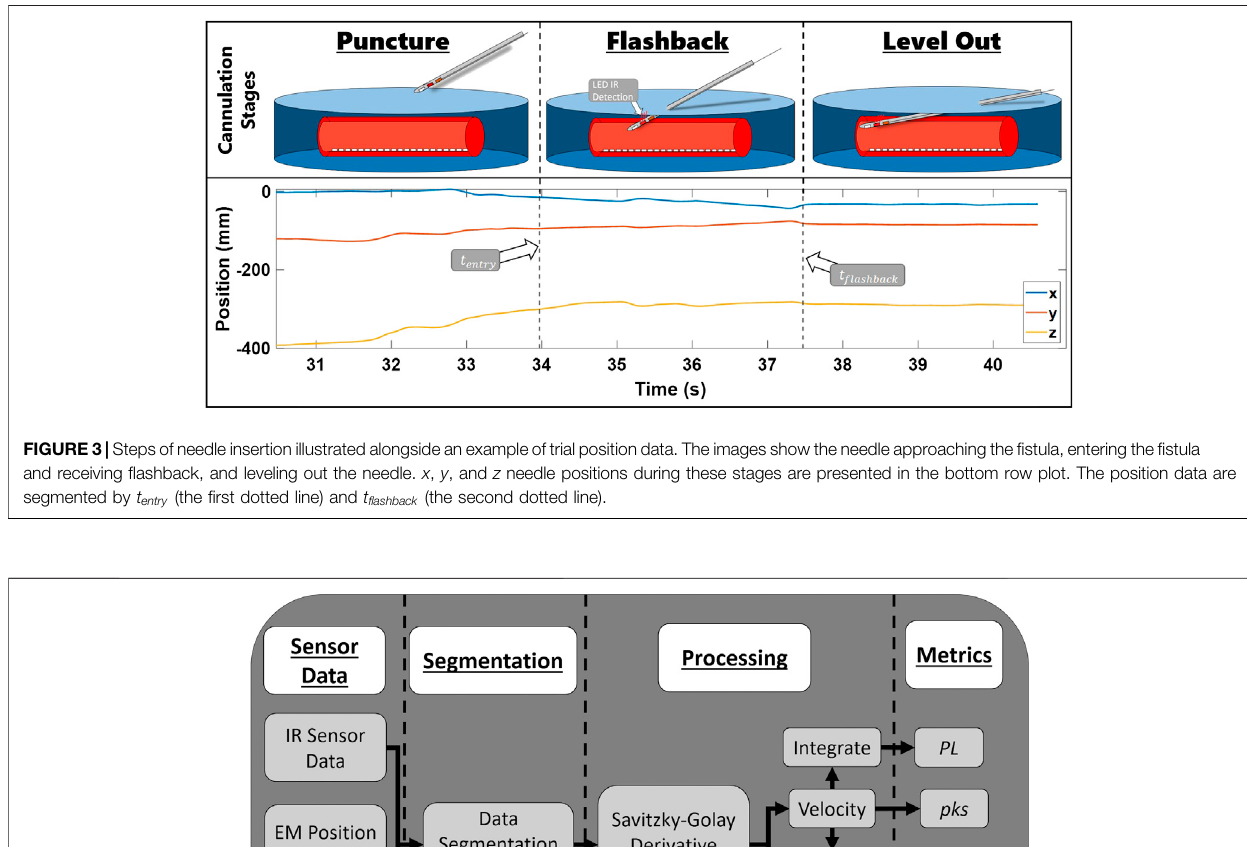
Frontiers in Robotics and AI |